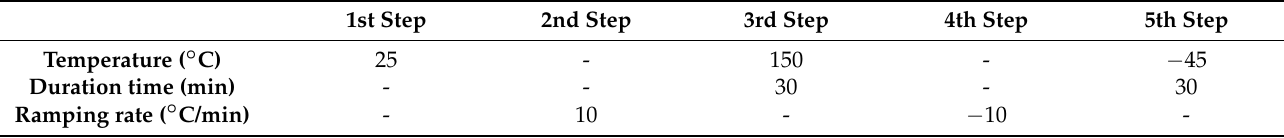
Figure 7. Experimental fixture for evaluation of leakage performance in gasket stack: ( a ) schematic diagram of overall fixture; ( b ) cross-section schematic diagram of fixture; ( c ) image of gasket and sealing plate; ( d ) image of assembled test fixture. Table 2. Thermal cycle profile applied to leakage test cell used in this study (repeated 10 times).